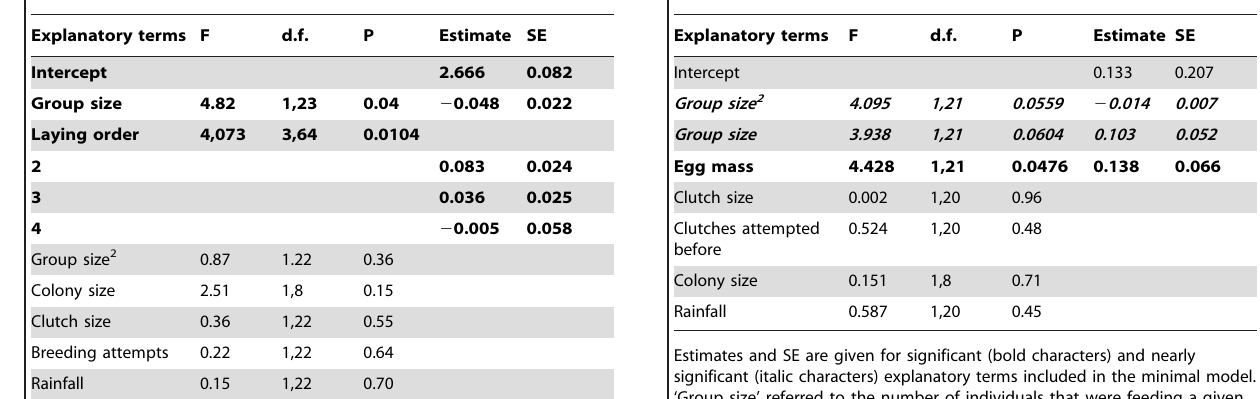
Table 2. Factors affecting egg mass.